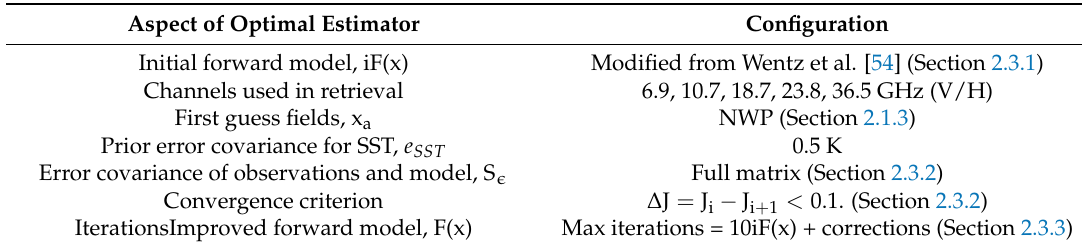
Table 2. Final optimal estimator